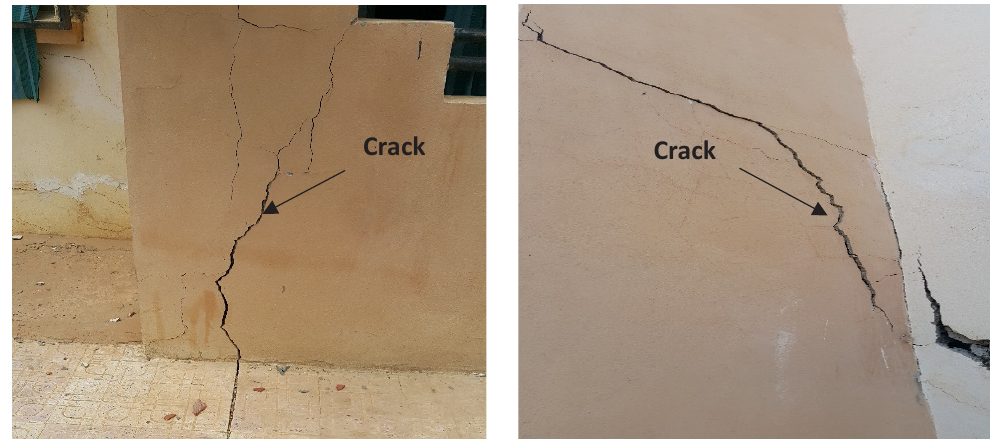
Figure 1: Example of damage of swelling soil in N’Gaous city.